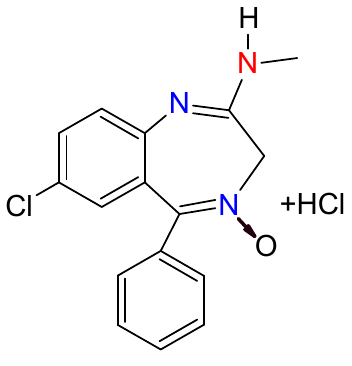
Figure 6. Chlordiazepoxide structure; it was the first benzodiazepine introduced in the world.